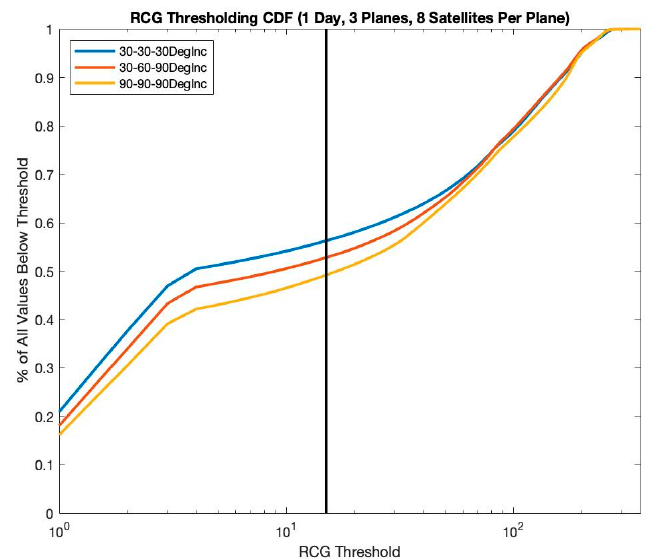
Figure 9. RCG Thresholding Comparison for 3-Plane constellations at 800 km, 16 parallel measure- ments per sampling, and with 8 satellites per plane. For all listed constellations, the fraction of measurements below threshold converges around RCG Value of 15.